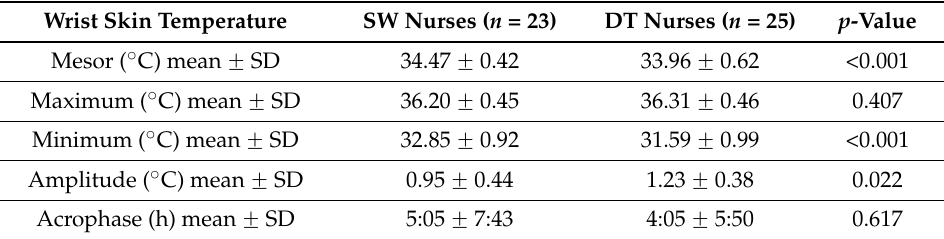
Table 2. Results of Cosinor analysis of wrist skin temperature of shift-working (SW) and daytime (DT) nurses.